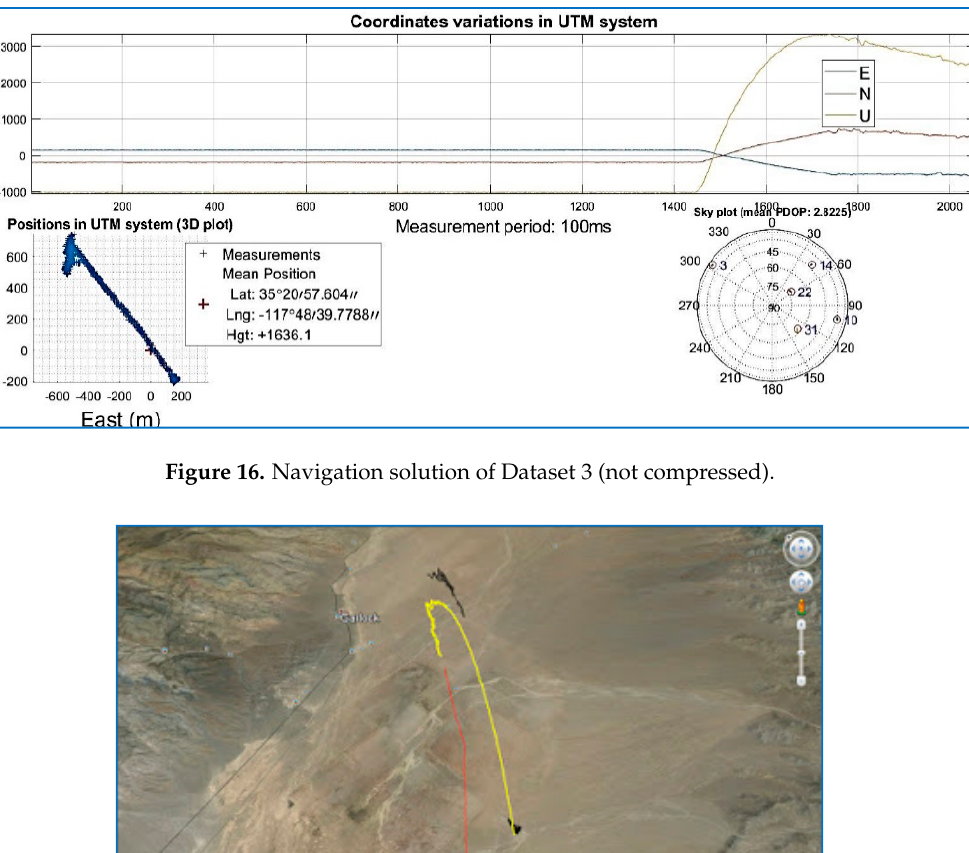
Figure 15. Frequency domain, histogram, real waveform, and raw I/Q of Dataset 3.